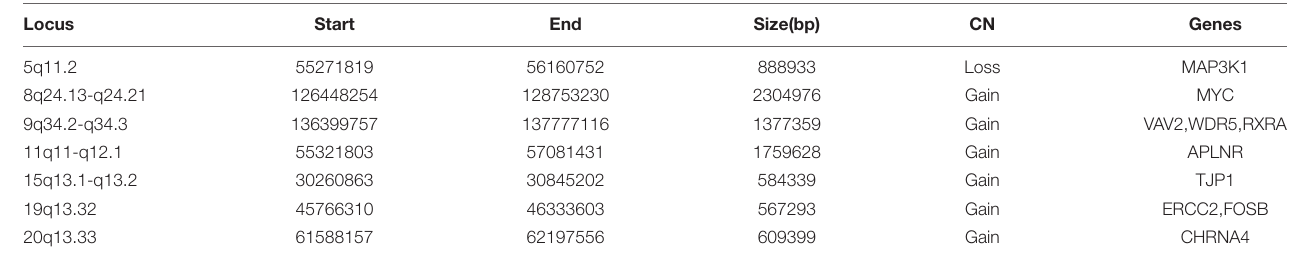
TABLE 3 | Copy number variant (CNV) in patients with PDA and identification of candidate genes. Locus Start End